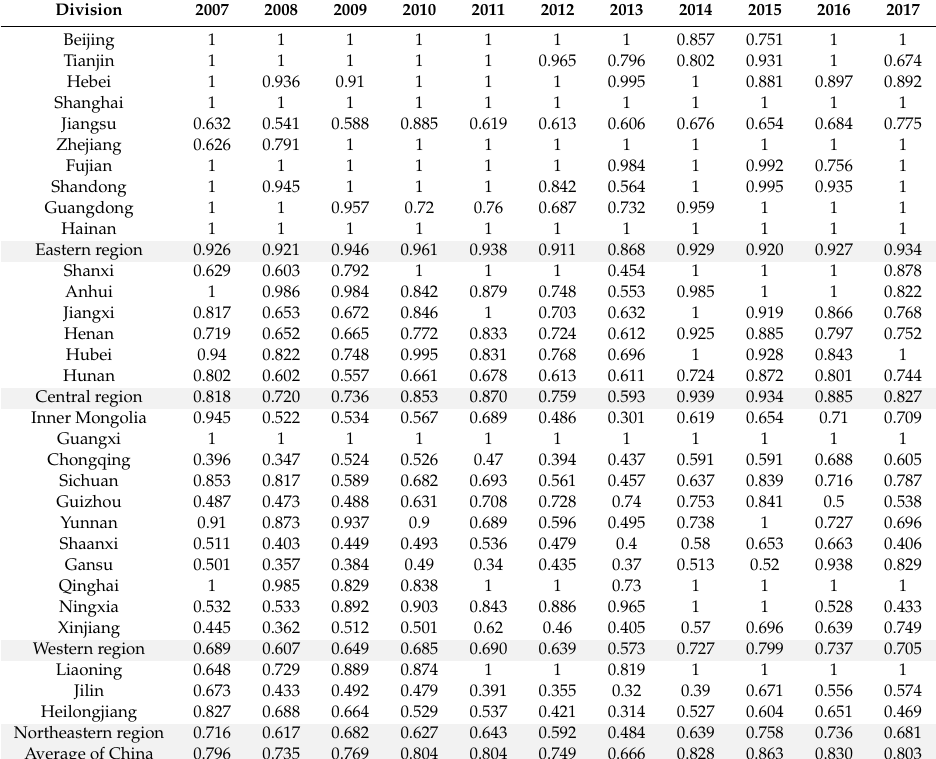
Table 2. Technical e ffi ciency (TE) values of fiscal policies for environmental pollution control in China